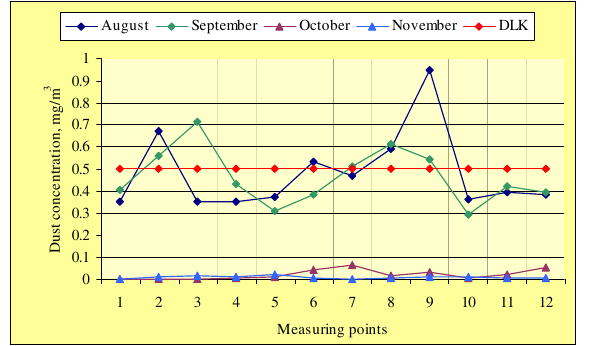
Fig 9 . Distribution of air dust concentrations in the territo- ry of the enterprise in the daytime In August concentrations in the evening were by 2 % higher than in September (Fig 10). Measurements in Au- gust and September conform with allowable norms and do not violate an allowable norm of 0,5 mg/m 3 . The hig- hest concentrations in August were detected at measuring points 3 and 7. These concentrations were close to HAC, at point 3 concentration was 0,466 mg/m 3 , at point 7 it was 0,454 mg/m 3 . In September concentrations were similar to those in August. The highest concentrations were detected at points 2 and 9. Their values were, res- pectively, 0,401 mg/m 3 and 0,407 mg/m 3 .